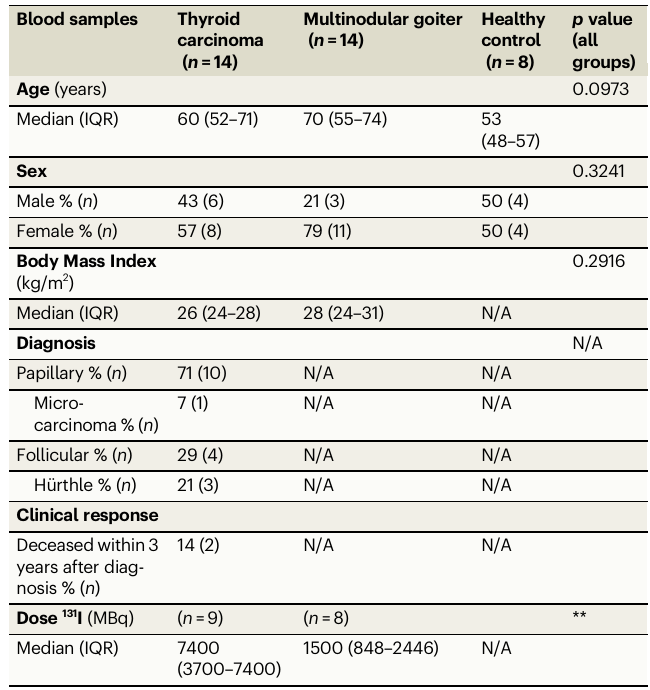
Table 1 | Baseline characteristics blood